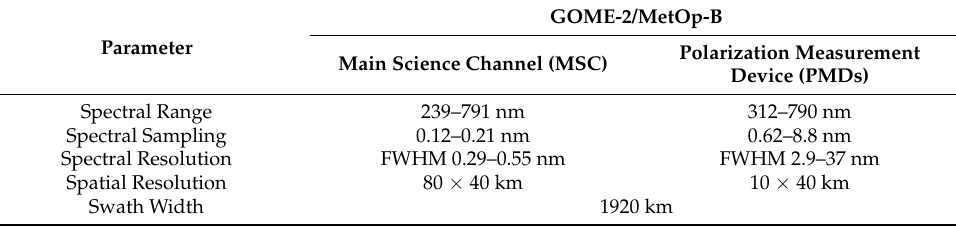
Table 1. Specifications of the Global Ozone Monitoring Experiment-2 (GOME-2)